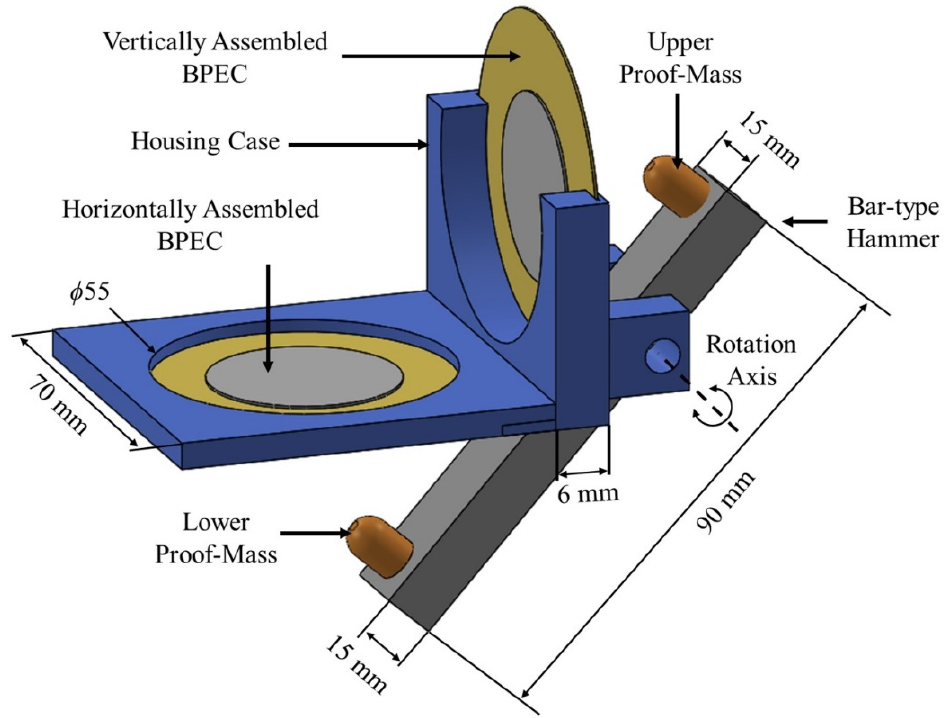
Figure 2. Illustration of hammer-impact-driven power generator using buzzer-type piezoelectric energy converter.